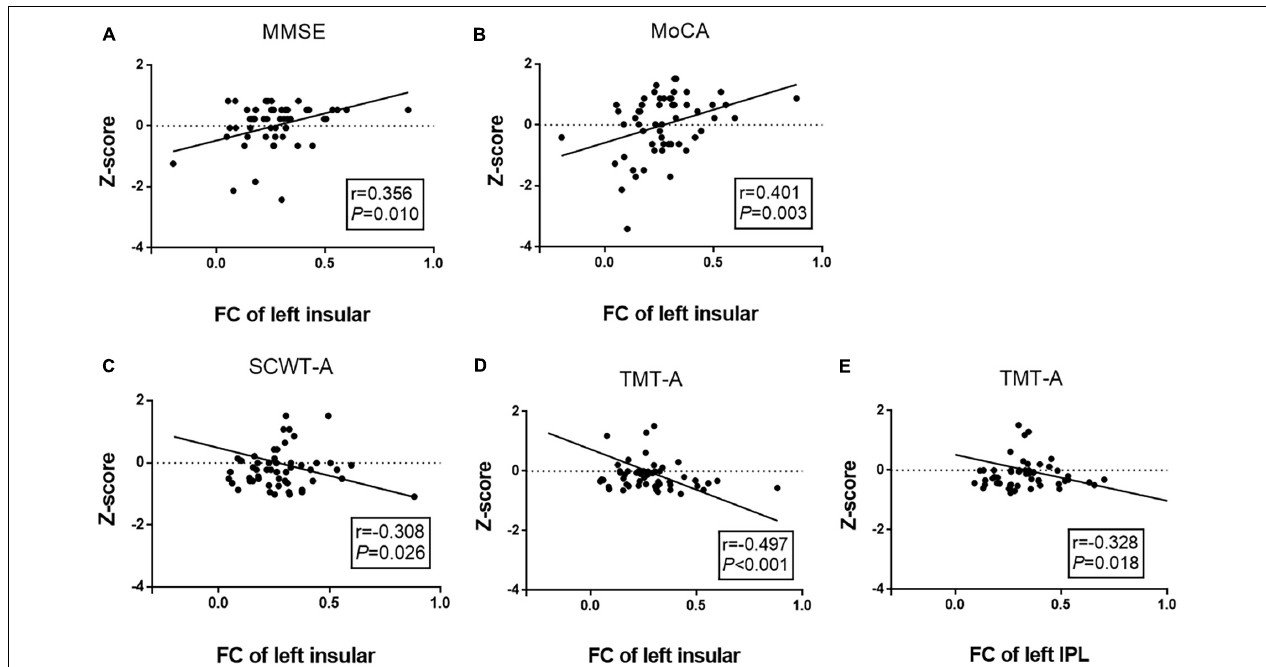
FIGURE 4 | Correlation analyses between FCs and cognitive function in the white matter hyperintensity (WMH)-III group. (A) The FC of the left insula-MOG was positively correlated with MMSE score ( r = 0.356, P = 0.010). (B) The FC of the left insula-MOG was positively correlated with the MoCA score ( r = –0.401, P = 0.003). (C) The FC of the left insula-MOG was negatively correlated with the time of SCWT-A ( r = –0.308, P = 0.026). (D) The FC of the left insula-MOG was negatively correlated with the time of TMT-A ( r = –0.497, P < 0.001). (E) The FC of the left IPL-MOG was negatively correlated with the time of TMT-A ( r = –0.328, P = 0.018). The scores were z-transformed scores of the relevant tests. FC, functional connectivity; IPL, inferior parietal lobule; MMSE, Mini-Mental State Examination; MoCA, Montreal Cognitive Assessment; SCWT, Stroop Color and Word Tests; TMT, Trail Making